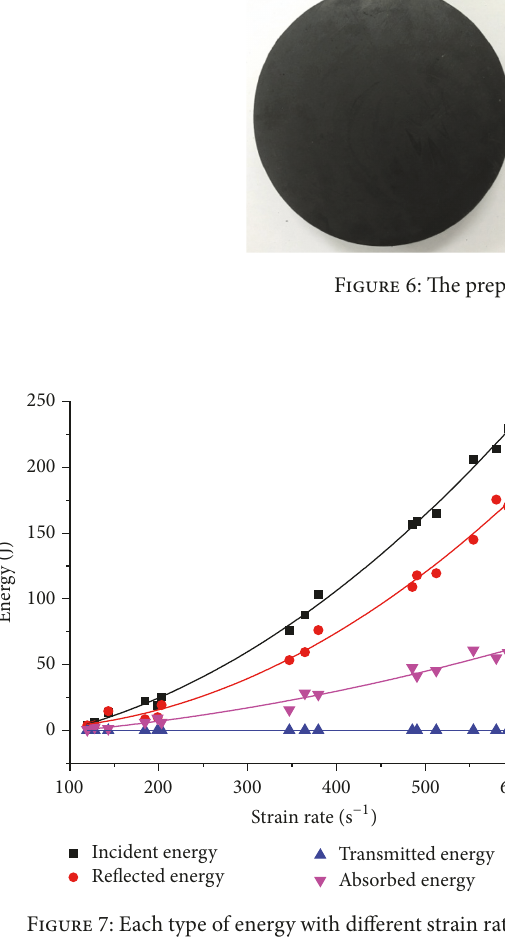
Figure 7: Each type of energy with different strain